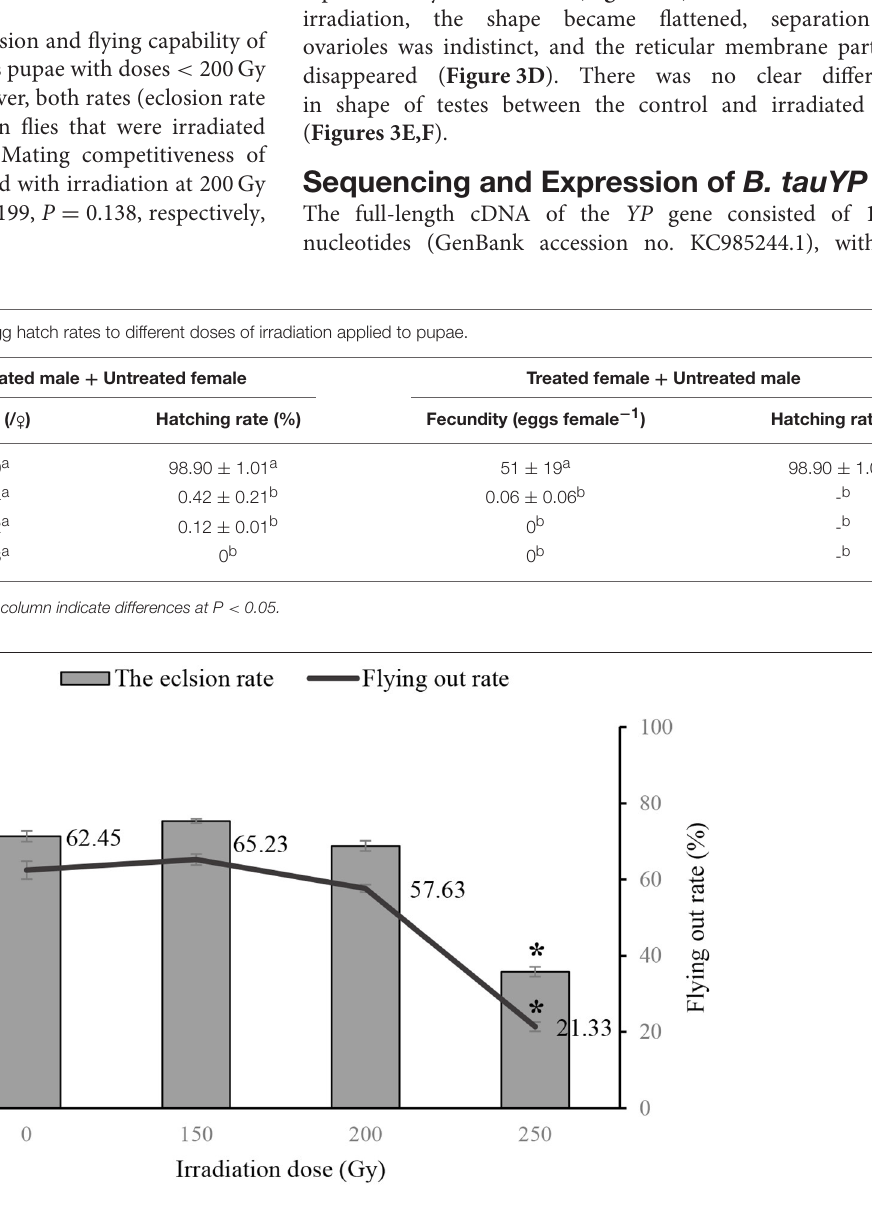
FIGURE 1 | Eclosion rates and flight capablity of flies treated with different doses of irradiation as pupae. * indicates difference at P < 0.05.